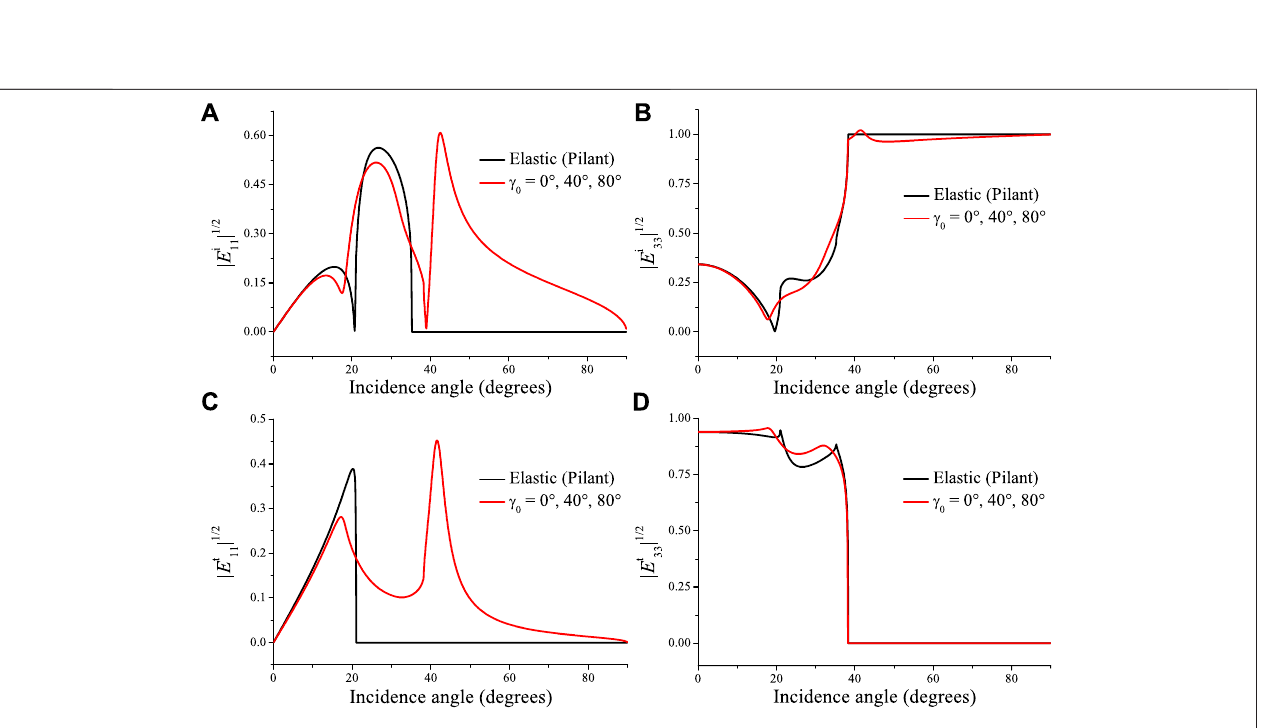
indicated. If the two media are elastic, there is a critical angle at approximately 40 ° . If the incident wave travels along the z - direction (vertical), an incident P wave will generate re fl ected